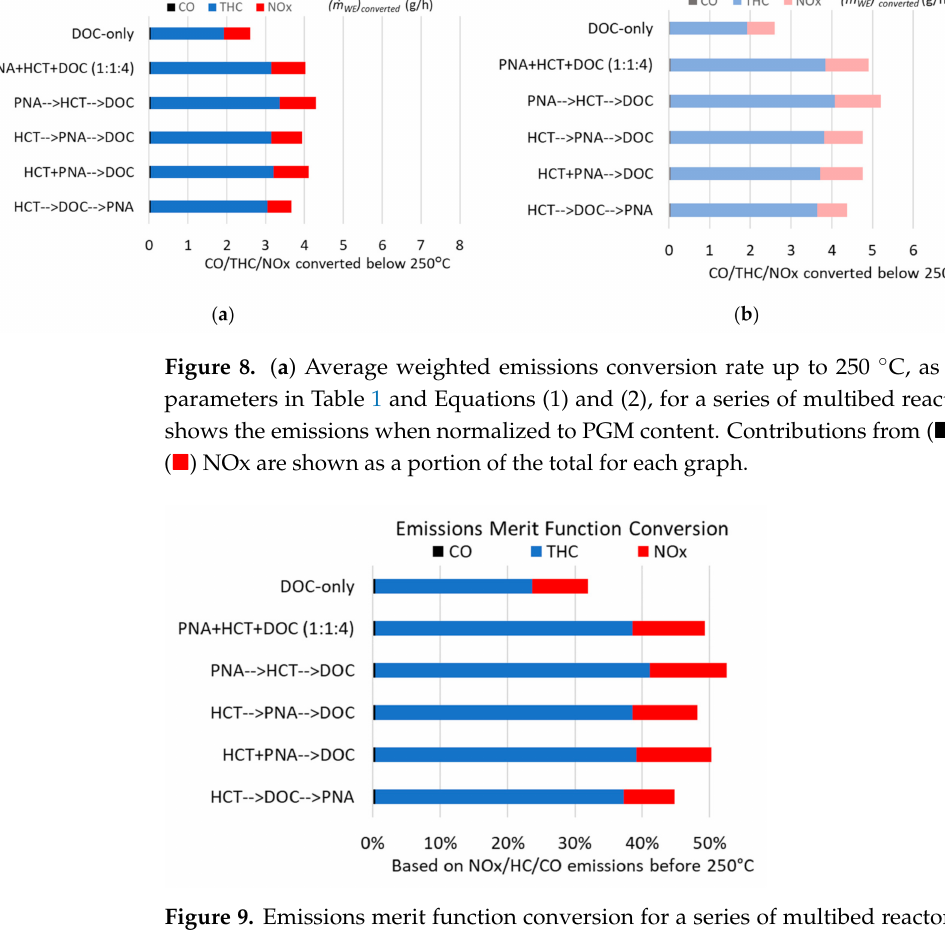
Figure 9. Emissions merit function conversion for a series of multibed reactor systems calculated from Equation (3) that represents the portion of the emissions that are converted up to 250 ◦ C. Contributions from ( (cid:4) ) CO, ( (cid:4) ) THC, and ( (cid:4) ) NOx are shown as a portion of the total for each graph.